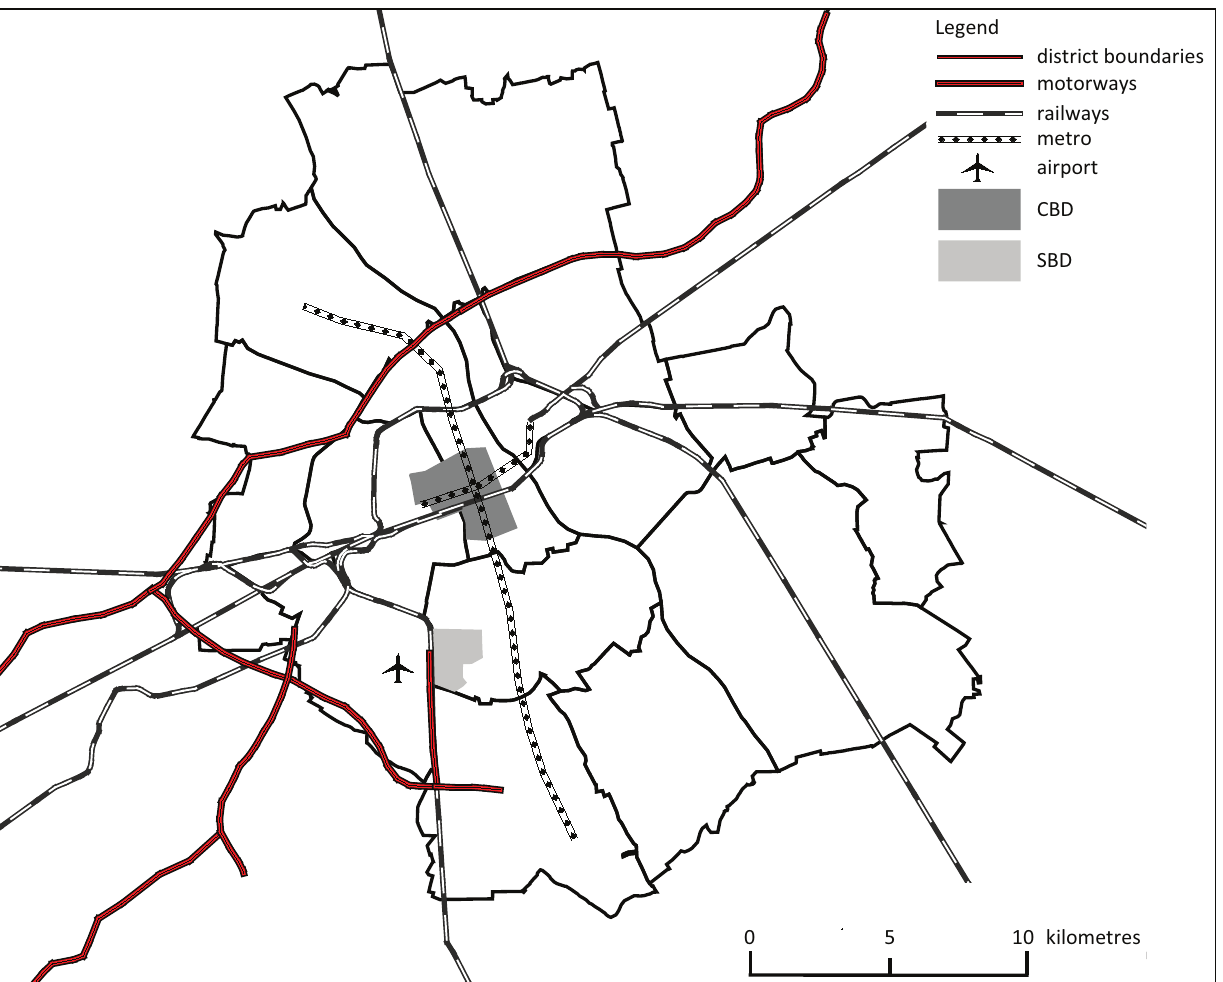
Figure 1. Location of the CBD and SBD in